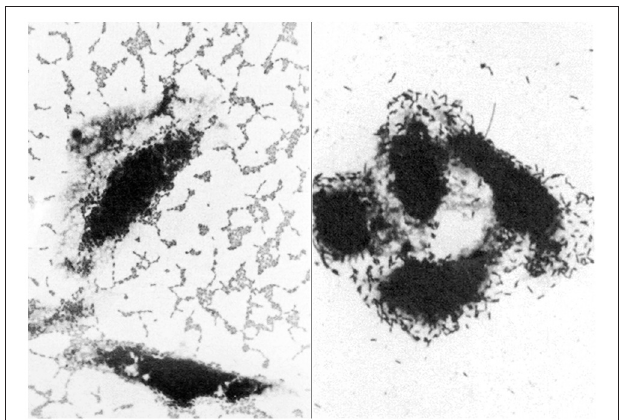
FIGURE 1 | Light micrographs showing the distinctive patterns of adherence of enteroaggregative E. coli (left) and diffusely-adherent E. coli (right) to cultured epithelial cells (adapted from Nataro et al., 1987). These patterns were responsible for the names of these pathotypes and were originally used to identify them in vitro